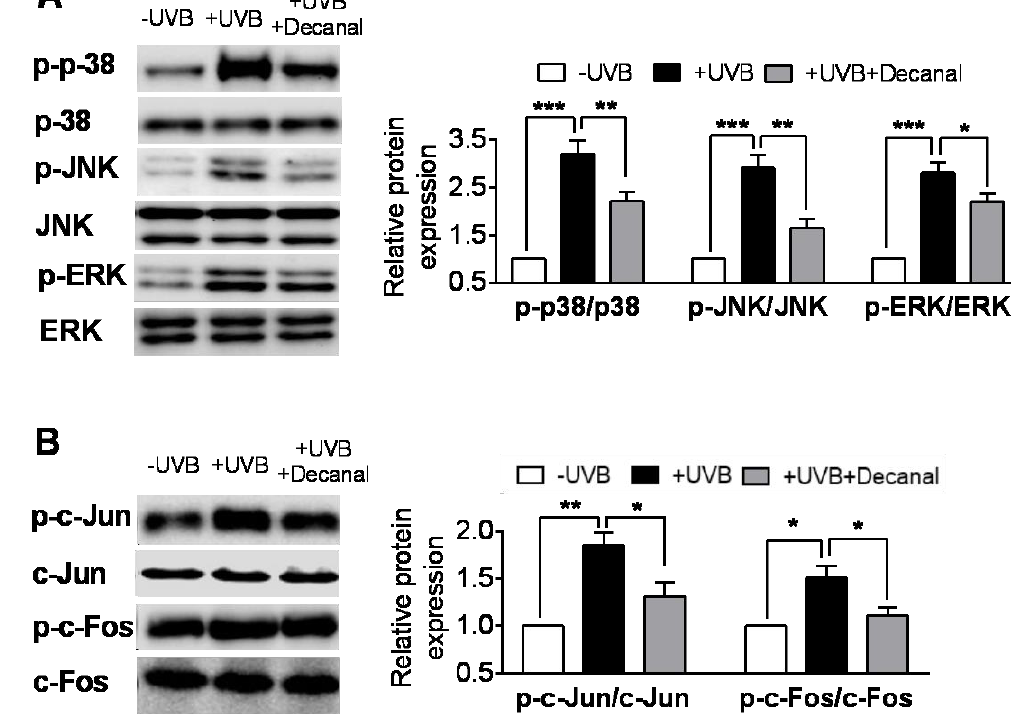
Figure 4. The effect of decanal on the UVB-induced mitogen-activated protein kinase (MAPK) pathway in Hs68 dermal fibroblasts. Hs68 cells were treated with either decanal or the vehicle and exposed to UVB. ( A ) Phosphorylation of MAPK proteins (p38, c-Jun N-terminal kinase (JNK) and extracellular-signal-regulated kinase (ERK)) and ( B ) c-Jun and c-Fos (MAPK downstream molecules) were determined. Data are shown as the mean ± SEM ( n = 3). Significant differences are indicated as * p < 0.05; ** p < 0.01; *** p < 0.001.